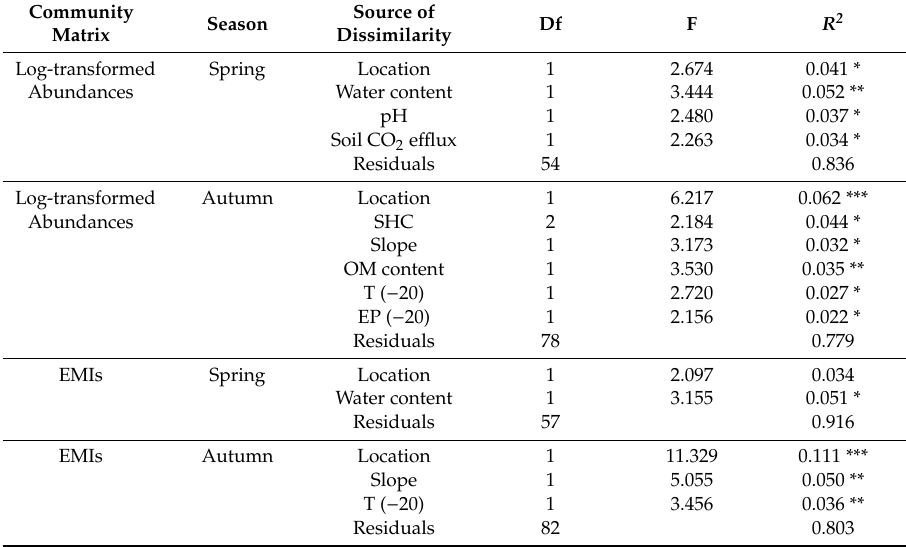
Table 3. PERMANOVA results for matrices of log-transformed abundances and eco-morphological index score matrices. Significant results for environmental parameters causing dissimilarity are marked with asterisk: (*) = p < 0.05; (**) = p < 0.01; (***) = p < 0.001. Location indicates if the sampling point was established beneath the tree canopy (In-C) or outside the canopy (Out-C); SHC indicates the characteristics of the surrounding environment and pressure of the livestock where sampling points were placed; EP (–20) = e ff ective precipitation of the 20 days prior to the sampling day; T (-20) = average temperature of the 20 days prior to the sampling